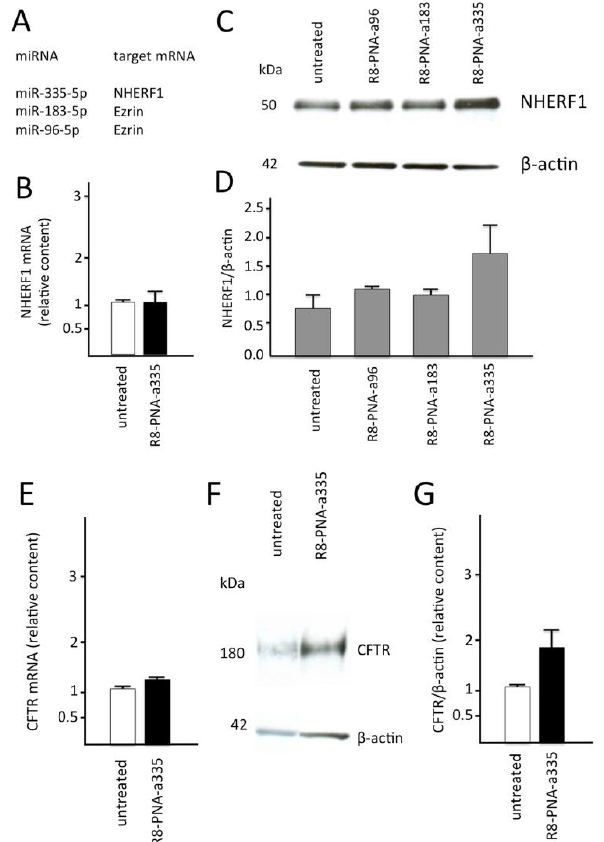
Figure 4. ( A ) The studied microRNAs and relative mRNA targets. Changes in NHERF1 ( B – D ) and CFTR ( E – G ) gene expression analyzed by RT-qPCR (B,E) and Western blotting ( C , D , F , G ) in samples from Calu-3 cells cultured for 72 h in the absence or in the presence of R8-PNA-a335-5p, as indicated. The mRNA regulated by the targeted miRNAs are outlined in panel A. Results are expressed as mean ± standard error of the mean (SEM) of at least three independent experiments. Changes in the content of NHERF1 ( C , D ) and CFTR ( F , G ) relative to ß-actin ( C , D , F , G ) are